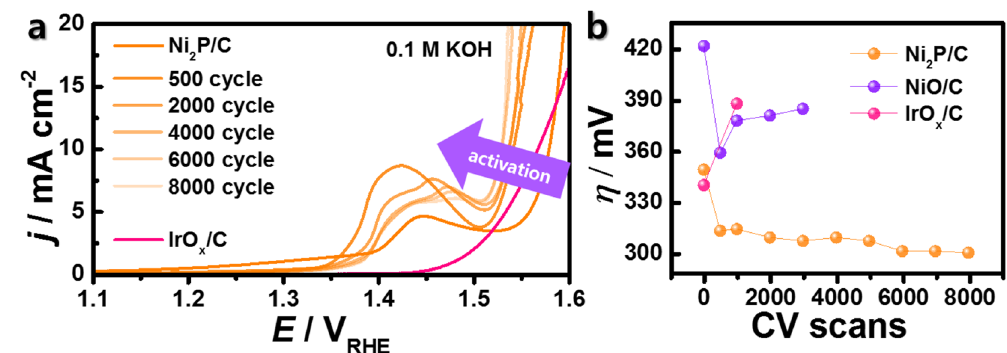
Figure 3. ( a ) Ohmic resistance-compensated polarization curves of the oxygen evolution reaction (OER) for Ni 2 P/C, and ( b ) overpotentials ( η ) at 10 mA cm − 2 of Ni 2 P/C and NiO/C with respect to the potential cycles. All measurements were performed in 0.1 M KOH saturated by high purity oxygen (99.999%) at room